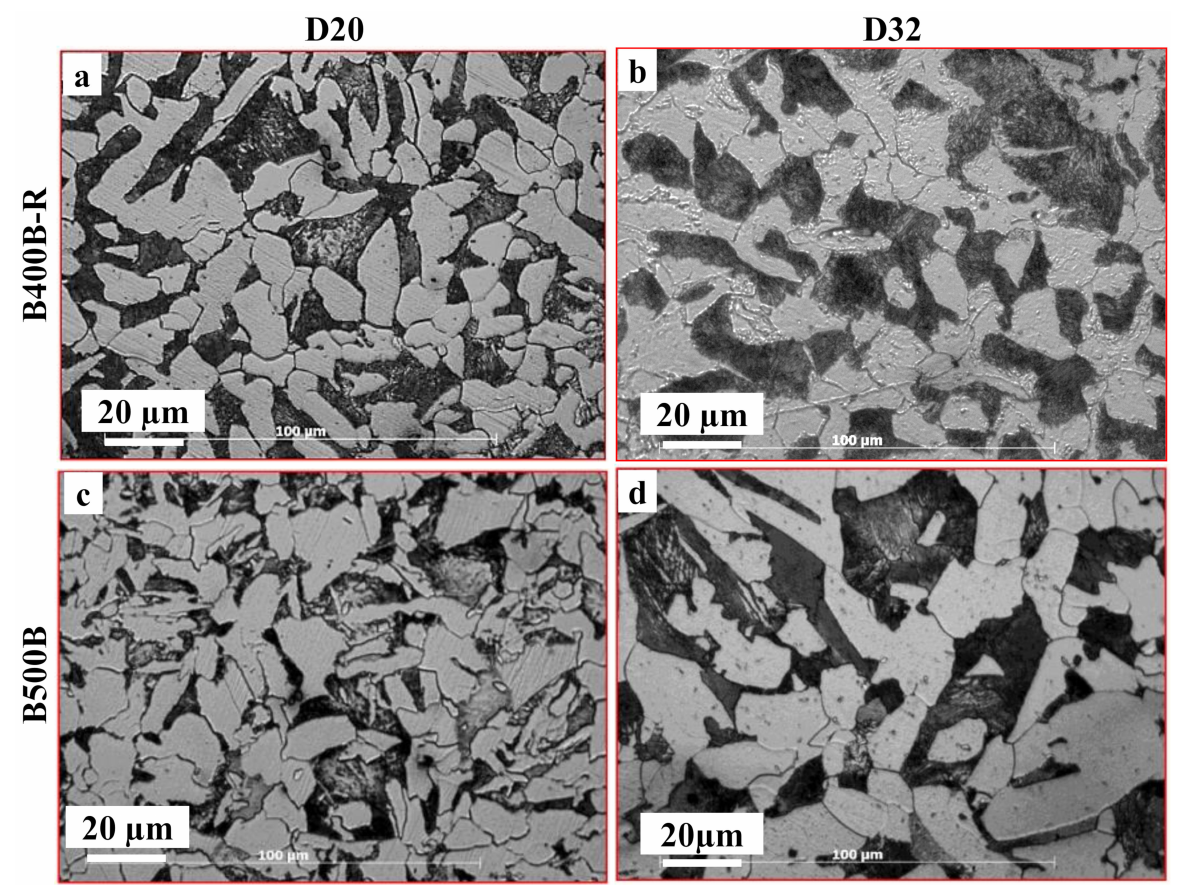
Figure 5. Optical micrographs showing the developed microstructures in the core zones ( a , b ) for D20 and D32 of B400B-R grade. ( c , d ) show the microstructure in the core zones for D20 and D32 of B500B steel